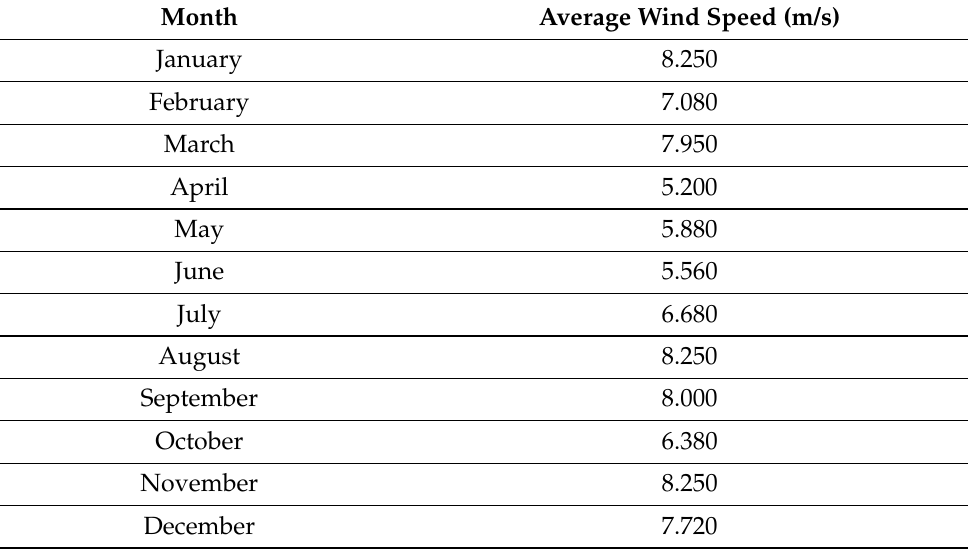
Table 3. Donoussa monthly average wind speed